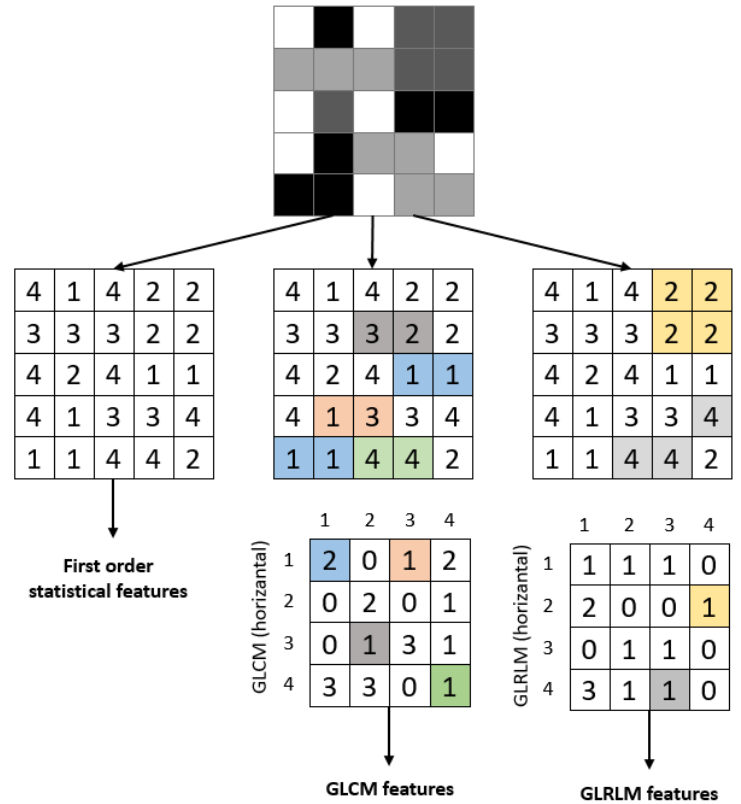
Figure 9. Calculating first-order statistical and textural features for a sample 5 × 5 image; whereas